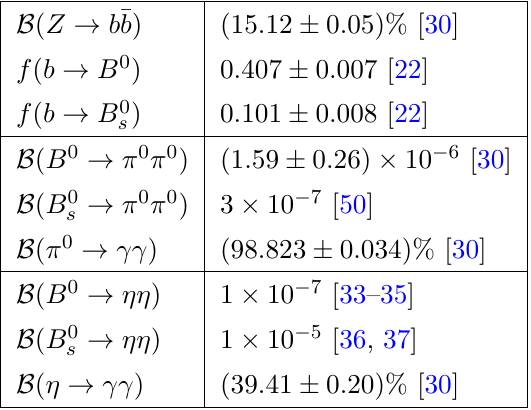
→ π 0 π 0 and B 0 → ηη at Tera- Z . ( s ) ( s ) produced in the fragmentation of b quarks, ( s )